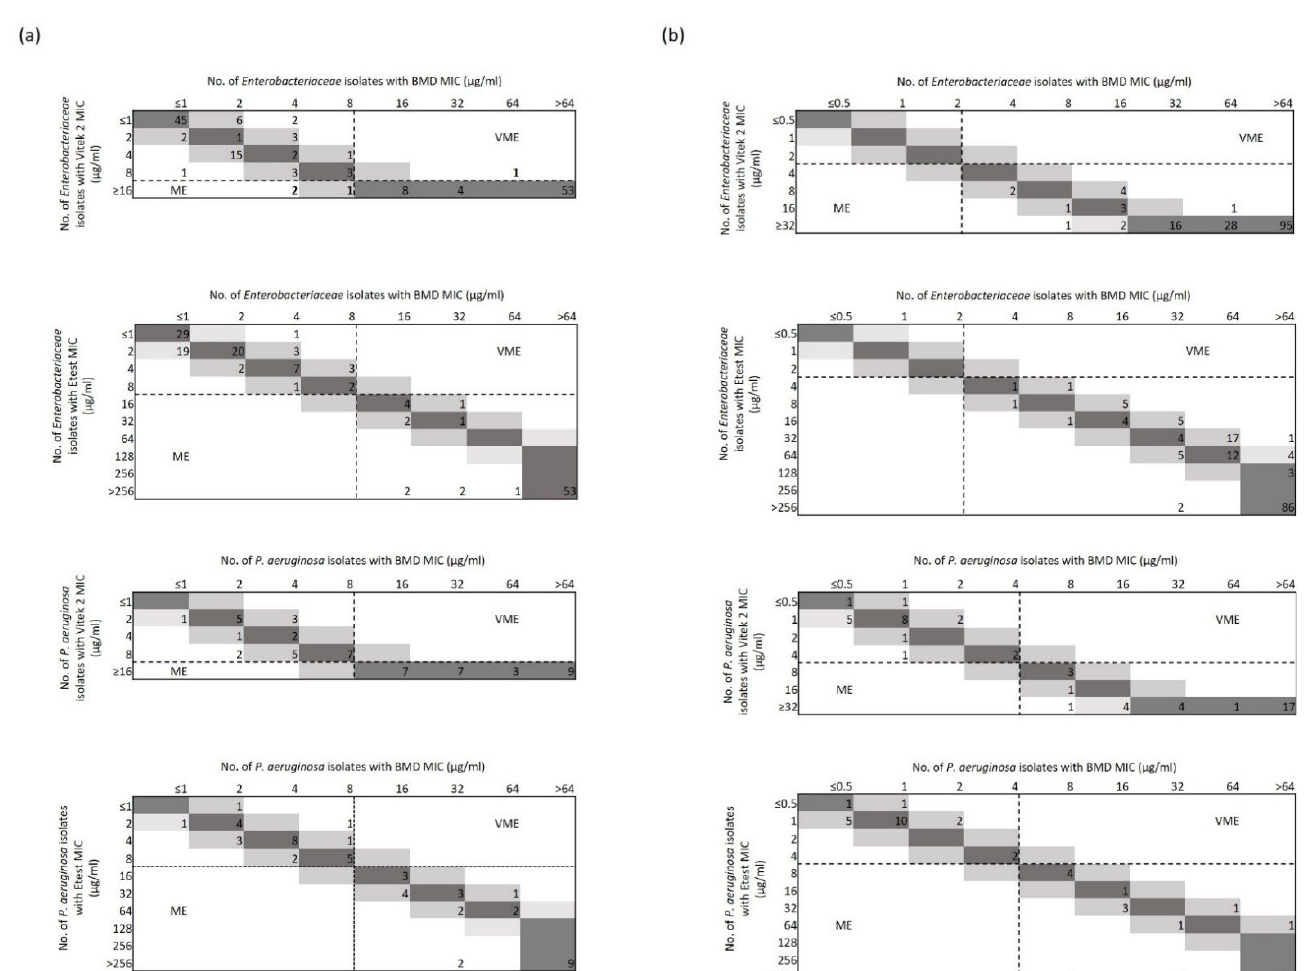
Figure 1. The correlation between ceftazidime/avibactam ( a ) and ceftolozane/tazobactam ( b ) MICs (expressed as µg/mL) obtained by testing Enterobacteriaceae ( n = 153) and P. aeruginosa ( n = 52) isolates with the BMD (reference), VITEK 2, or ETEST methods, respectively. Darker and lighter grey squares indicate, respectively, the number of isolates with a VITEK 2 or ETEST MIC corresponding to the BMD MIC and 1-log 2 concentration for each of two antimicrobial agents. Numbers outside the squares indicate the isolates with VITEK 2 or ETEST MICs that differed by more than 1-log 2 concentration from the BMD MIC, which determined essential agreement rates below 100% for ceftazidime/avibactam or ceftolozane/tazobactam, respectively. Dashed lines delimitate VME or ME areas to represent, respectively, the isolates falsely categorized as susceptible or resistant according to EUCAST clinical breakpoints.